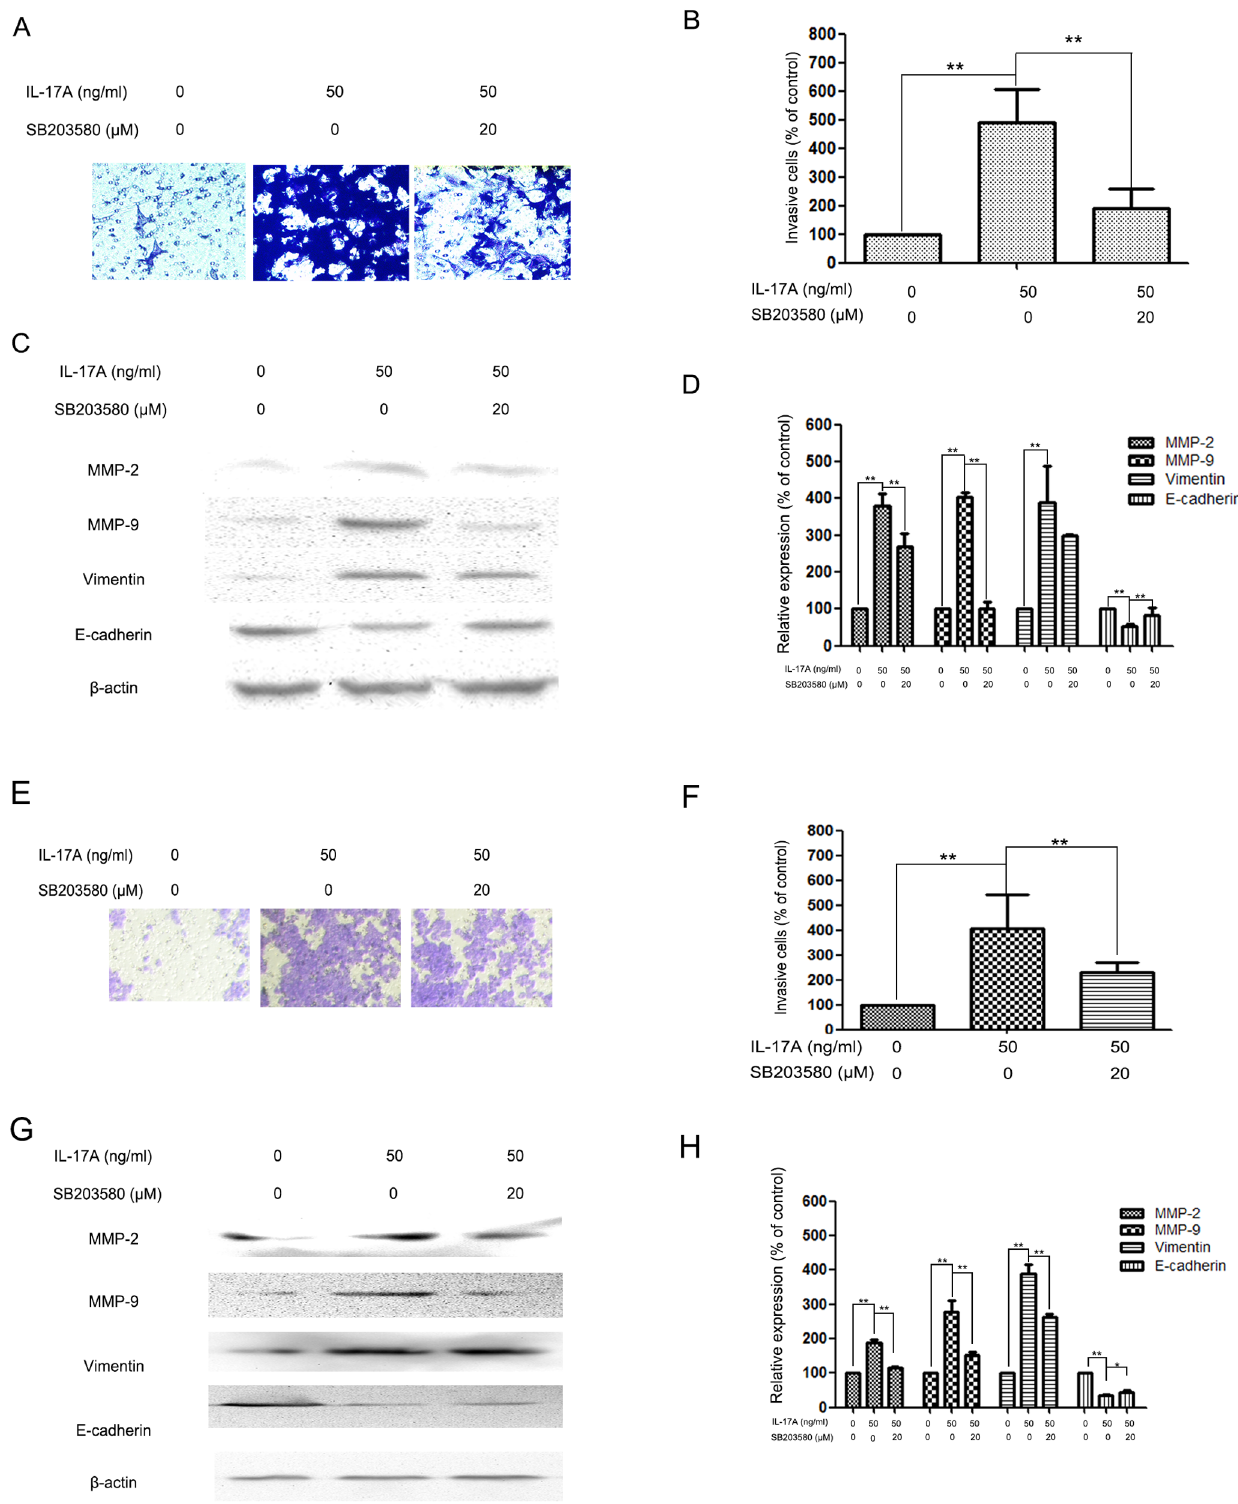
Figure 4. Effects of the p38 inhibitor and IL-17A on cell invasion and MMP-2, MMP-9, Vimentin and E-cadherin expressions in NPC- 039 and CNE-2Z cells. (A) NPC-039 cells were pretreated with SB203580 (20 m M) for 30 min and then incubated in the presence or absence of IL- 17A (50 ng/ml) for 24 h. Cellular invasiveness was measured using the transwell invasion assay. (B) The percent invasion rate in NPC-039 cells was expressed as a percentage of control. (C, D) NPC-039 cells were treated and then subjected to western blotting to analyze the protein levels of MMP- 2/-9, Vimentin and E-cadherin. (E) CNE-2Z cells were pretreated with SB203580 (20 m M) for 30 min and then incubated in the presence or absence of IL-17A (50 ng/ml) for 24 h. Cellular invasiveness was measured using the transwell invasion assay. (F) The percent invasion rate in CNE-2Z cells was expressed as a percentage of control. (G, H) CNE-2Z cells were treated and then subjected to western blotting to analyze the protein levels of MMP- 2/-9, Vimentin and E-cadherin. Values represent the means 6 SD of three independent experiments performed in triplicate. * p , 0.05 and ** p , 0.01 compared with the control group. doi:10.1371/journal.pone.0108060.g004 PLOS ONE |